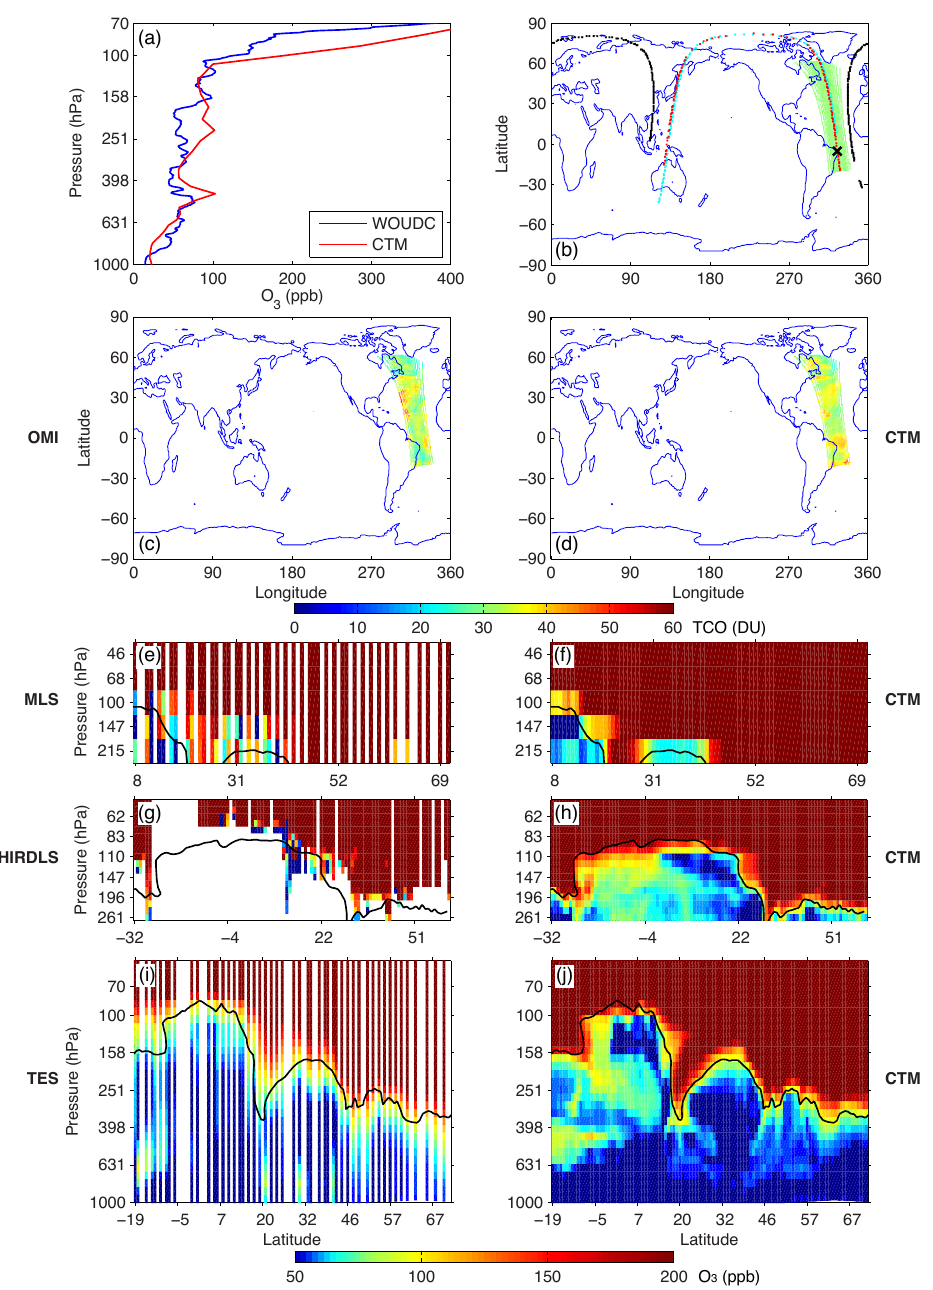
Fig. A6. Same as Fig. A5 for 19 December 2005. The sonde was measured at